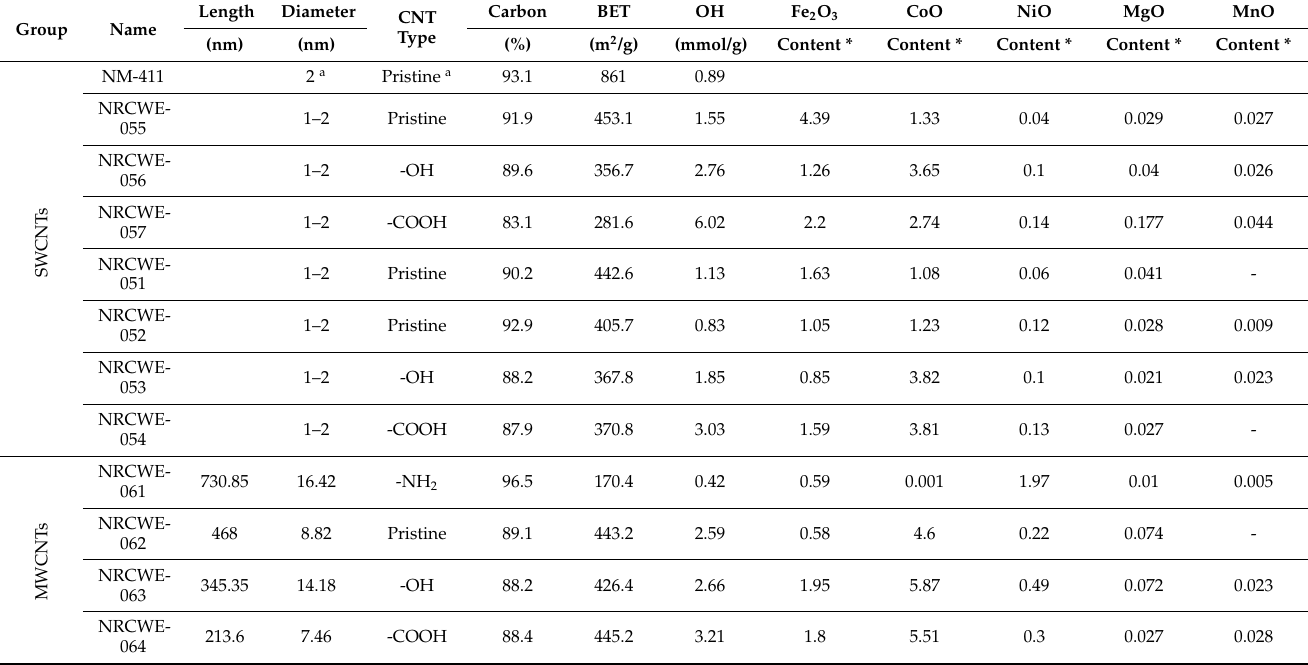
Table 1. Physico-chemical properties of CNTs as determined with combustion elemental analysis, BET, SEM and